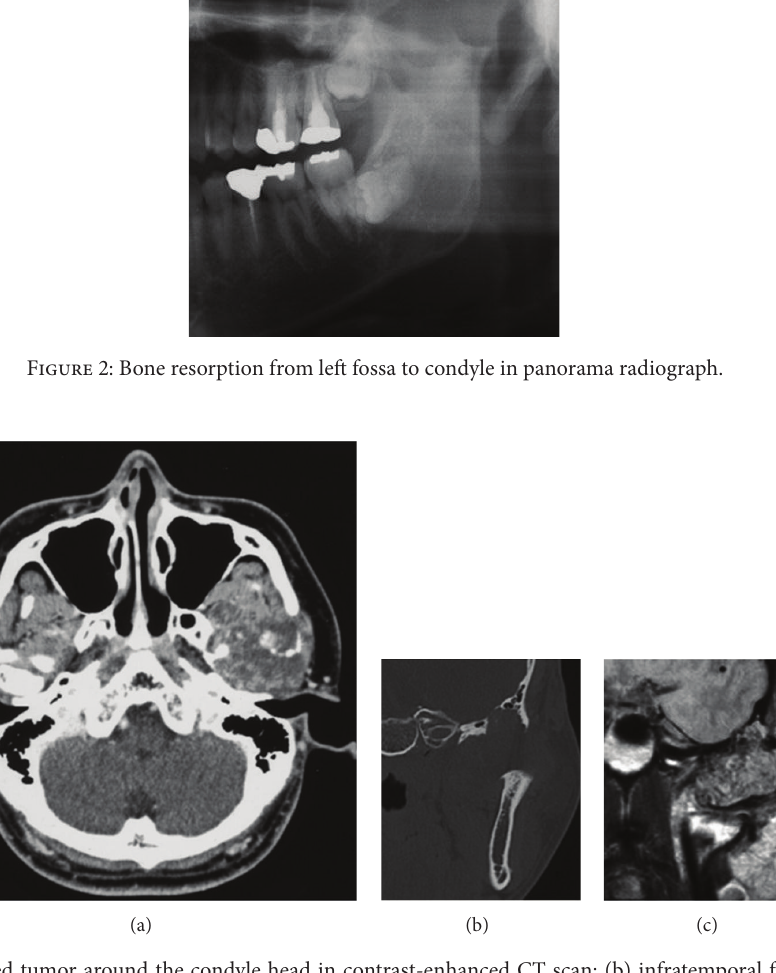
Figure 3: (a) Low-enhanced tumor around the condyle head in contrast-enhanced CT scan; (b) infratemporal fossa erosion and middle cranial invasion of tumor in coronal view of CT scan; (c) tumor expansion close to dura in enhanced